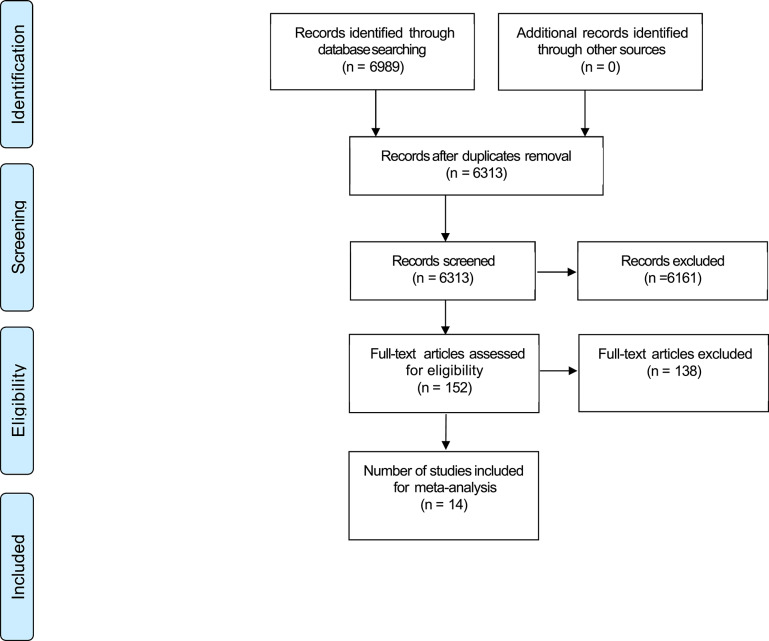
PRISMA flowchart.